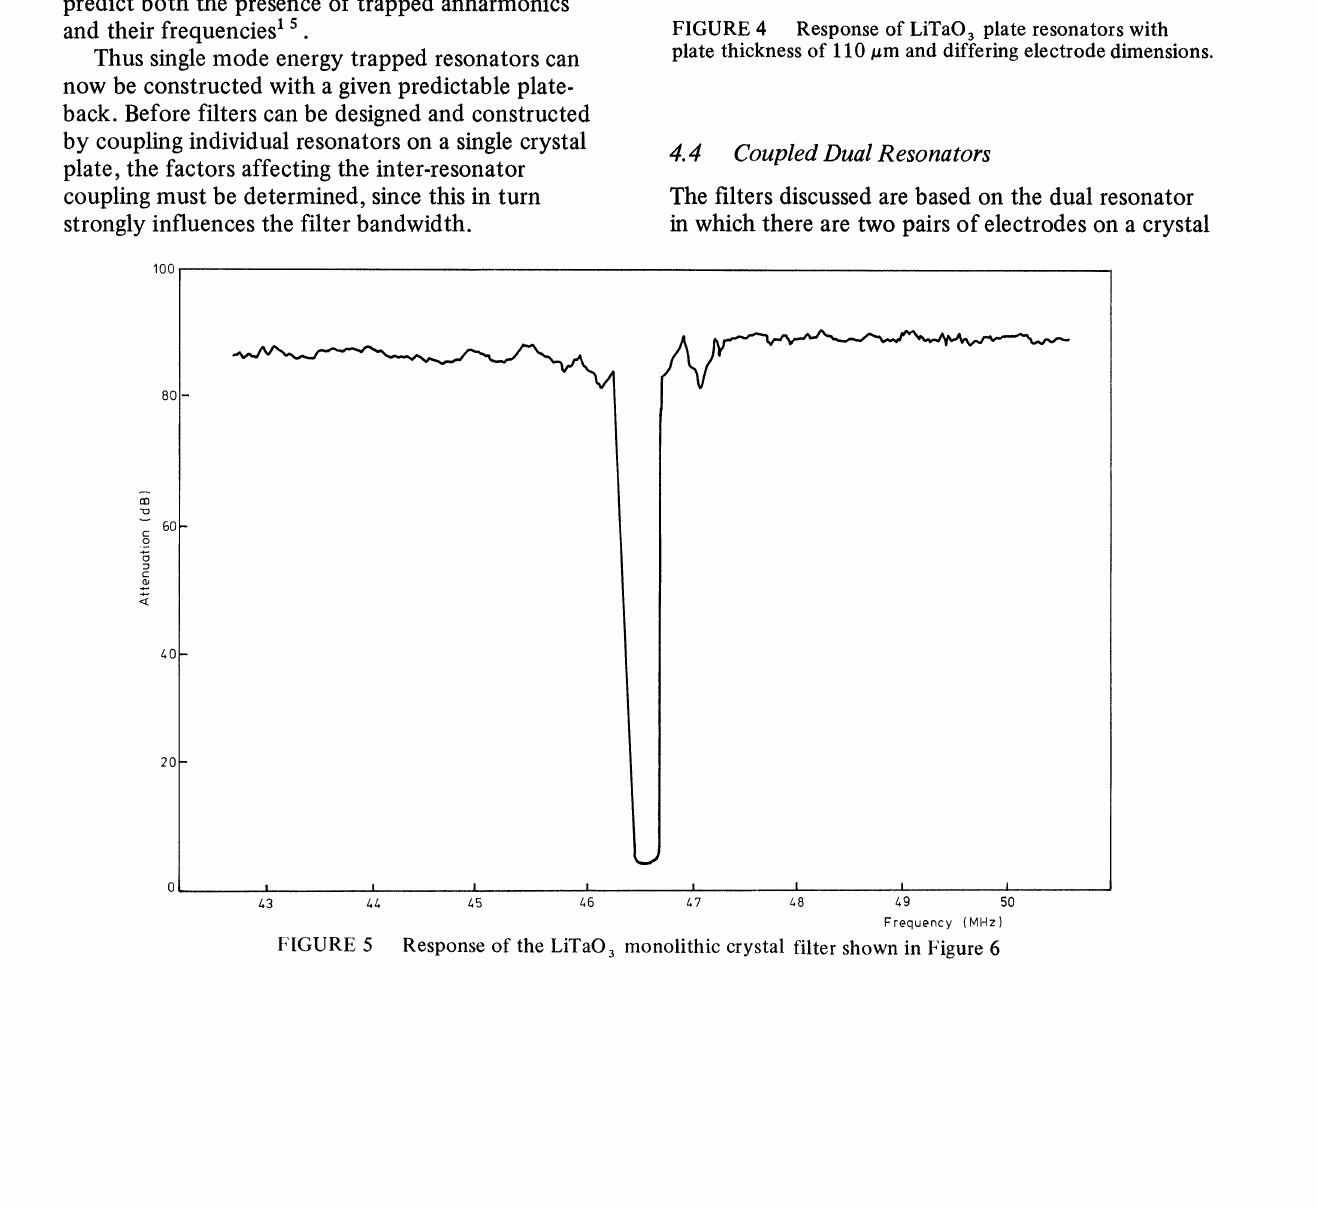
Response of LiTaO plate resonators with plate thickness of 110 m and differing electrode